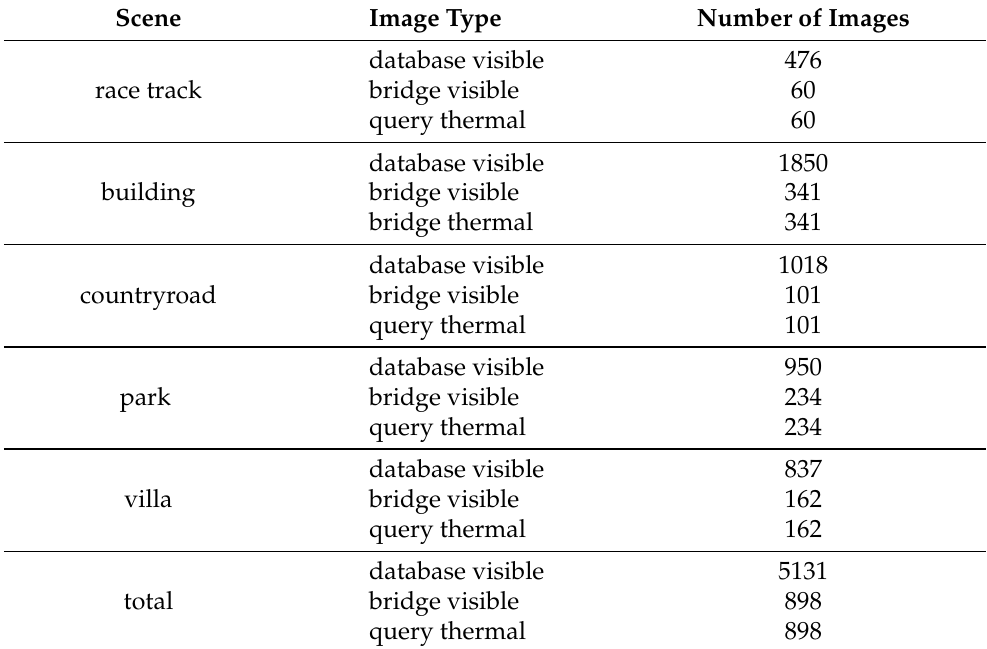
Table 3. Number of various images.